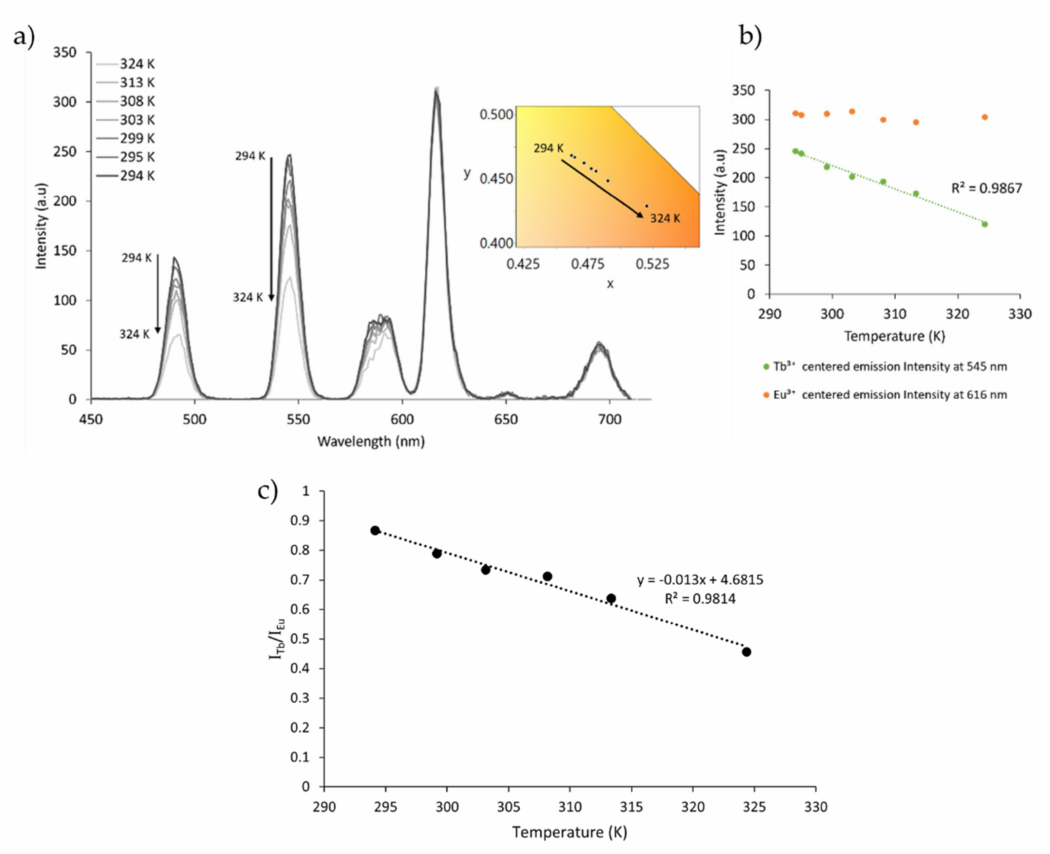
Figure 6. ( a ) Fluorescence spectra of Eu( 1 ) 3 :Tb( 1 ) 3 at varying temperatures ≈ 294 to 330 K (excitation and emission slit widths 3 and 5 nm, respectively). Insert: CIE 1931 chromaticity diagram of resulting colour change dependent on temperature, CIE coordinates: 294 K—x,y = 0.46, 0.47; 295 K—x,y = 0.46, 0.47; 299 K—x,y = 0.47, 0.46; 303 K—x,y = 0.48, 0.47; 308 K—x,y = 0.48, 0.46; 313 K—x,y = 0.49, 0.45; 324 K—x,y = 0.52, 0.43. ( b ) Emission intensity vs temperature monitoring emission at 616 nm for Eu 3+ and 545 nm for Tb 3+ . ( c ) Ratio of integrated Eu 3+ and Tb 3+ emission intensities vs